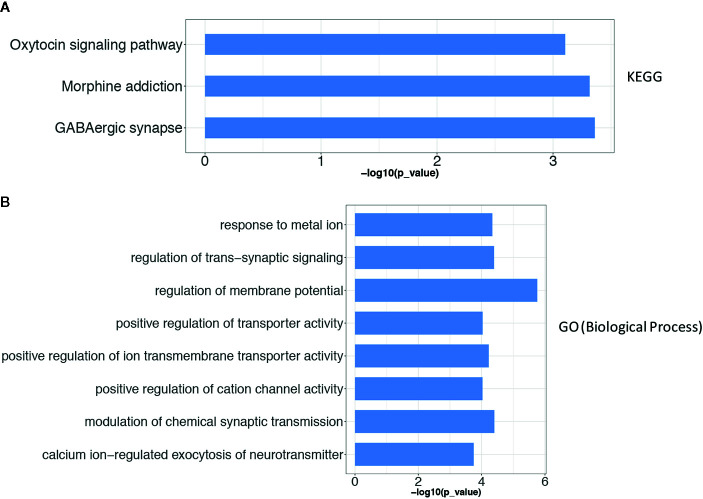
The results of the gene enrichment of identified DEGs. (A) KEGG pathway enrichment results; (B) GO term (Biological Process) function enrichment results. The Over-Representation method of the “clusterProfiler” package in R was used to enrich the GO and KEGG respectively.